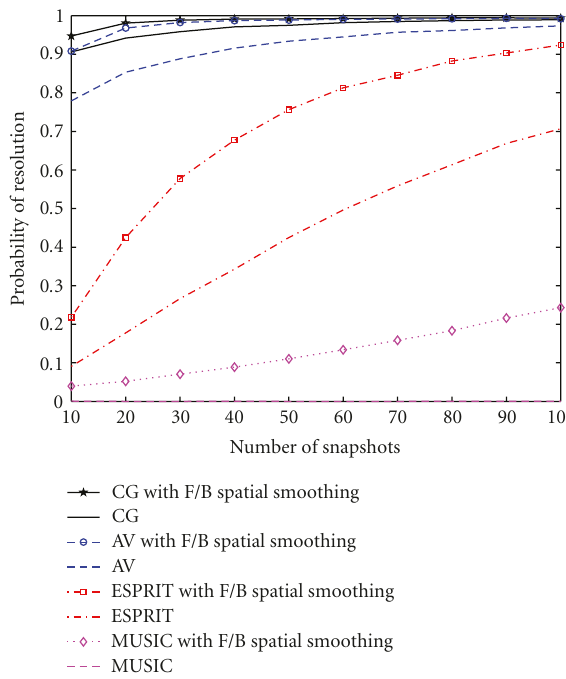
Figure 5: Probability of resolution versus number of snapshots (separation 3 ◦ , SNR = 5dB, r = 0 .